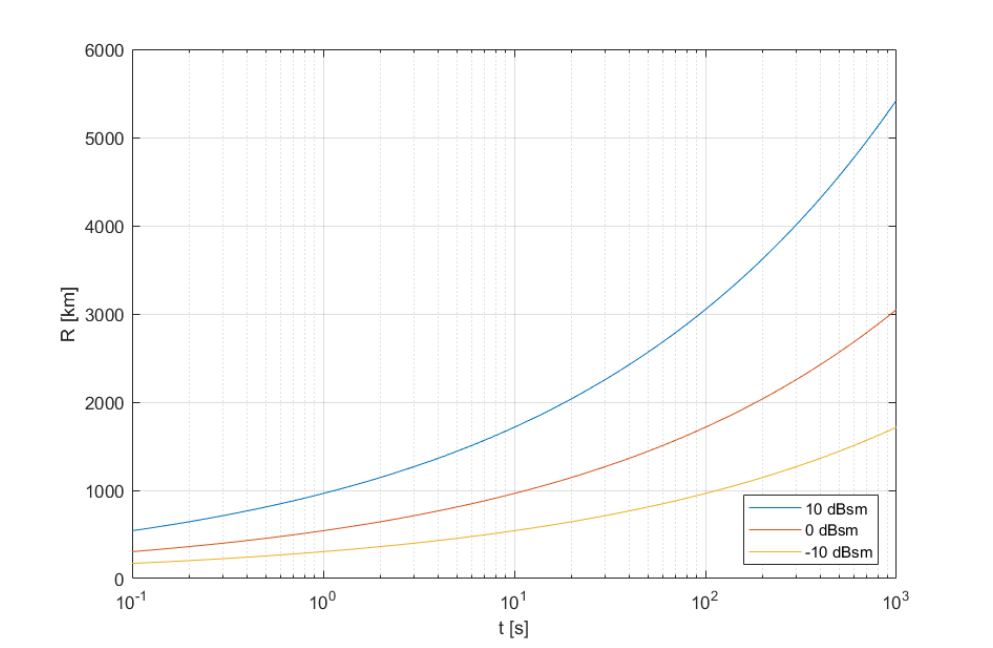
Figure 4. Detection range (quasi-monostatic) for different integration times.